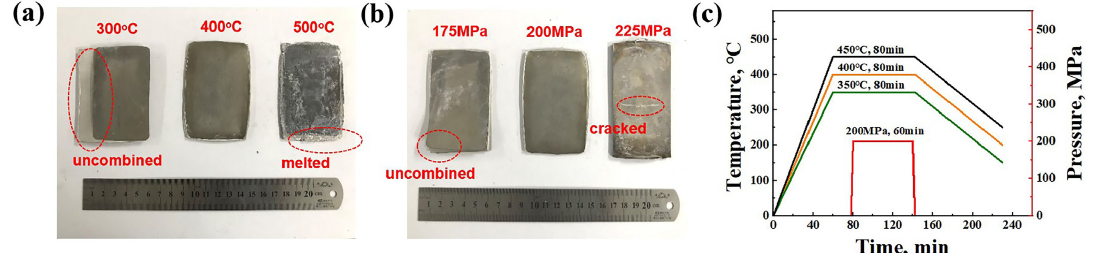
Figure 3. Exploration of (a) temperature at 200 MPa and (b) pressure at 400 o C during the preparation of LMCs, (c) the preparation technology of Ti/Al/Mg/Al/Ti LMCs.